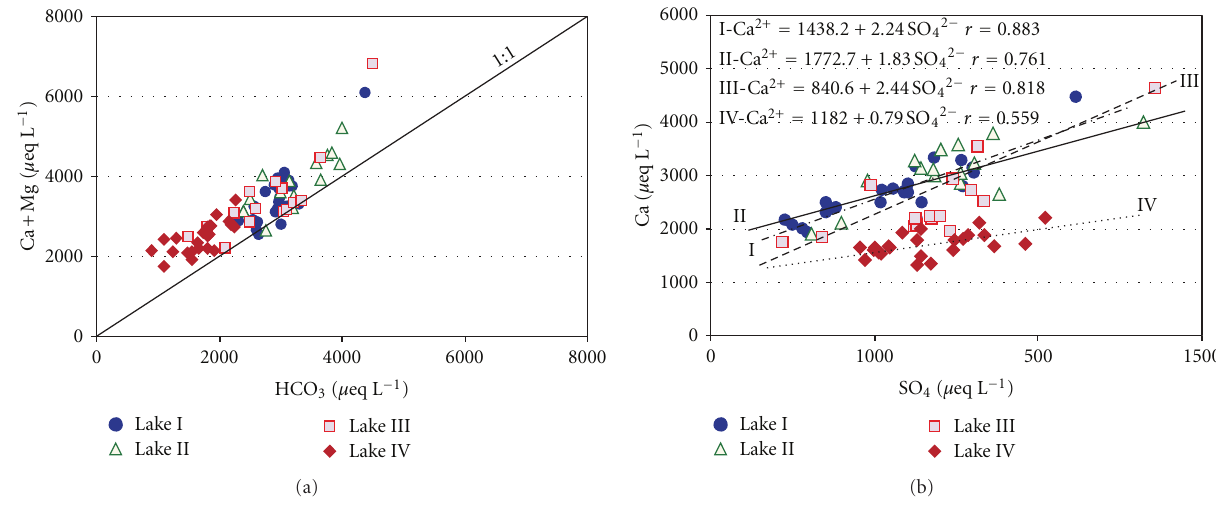
Figure 5: Scatter plots showing relationships between: (a) HCO 3 − – [Ca 2+ + Mg 2+ ] and (b) SO 42 − – Ca 2+